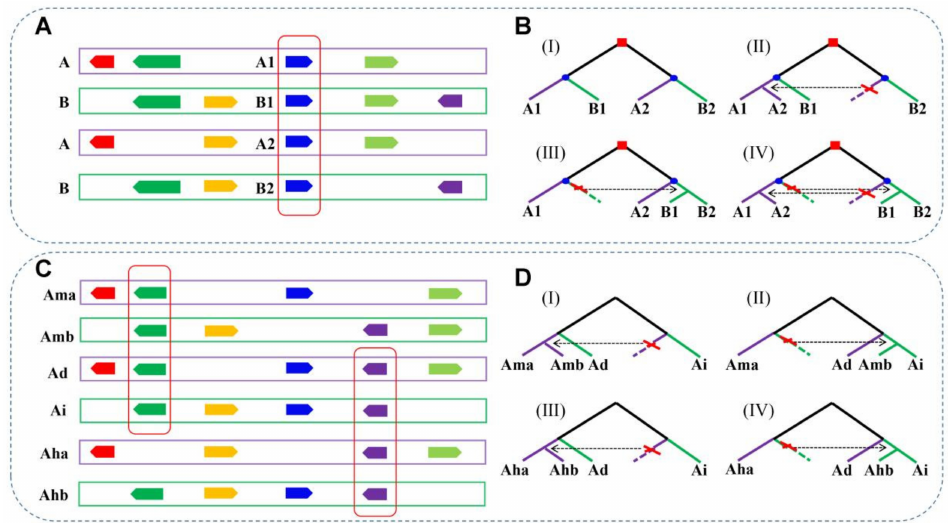
Figure 1. Homologous gene quartets and inference of conversion through phylogenetic analyses. ( A ) Colinear chromosomal segments from two genomes ( A , B ), represented by rectangles of different colors. Arrows show genes and homologous genes are coded by the same color. Homologous gene quartet formed by paralogous genes A1 and A2 in A and their respective orthologous genes B1 and B2 in B. ( B ) Squares indicate the WGD event in their common ancestral genome and circles symbolize species divergence. The expected phylogenetic relationship and potential conversion event of the homologous quartets: (I) the expected phylogenetic relationship of the homologous genes in quartet if no conversion occurs; (II) A2 (acceptor) is converted by A1 (donor); (III) B1 is converted by B2; (IV) both of the above conversions occurred. ( C ) Homoeologous chromosomal segments from A. duranensis , A. ipaensis , A. monticola and A. hypogaea . ( D ) The phylogenetic relationship of conversions between PRT-related duplicated